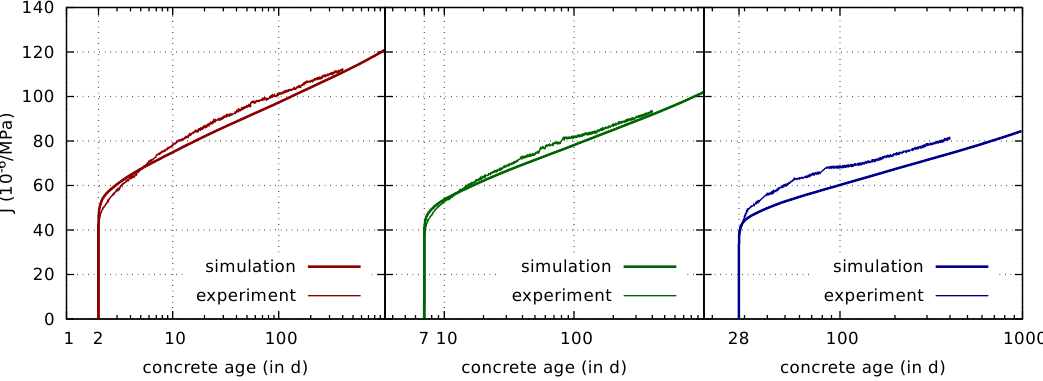
Figure 7. Comparison of measured [7] and computed basic creep compliances for loading at concrete ages of 2 days ( left ), 7 days ( center ), and 28 days ( right ), respectively. The drying creep tests were used to calibrate a single missing parameter of the creep model, the parameter c 1 in (27), which governs the delay in the decay of the microprestress upon drying. It is fitted using the measured drying creep compliances. The results in Figure 8 are obtained for c 1 = 10 MPa.